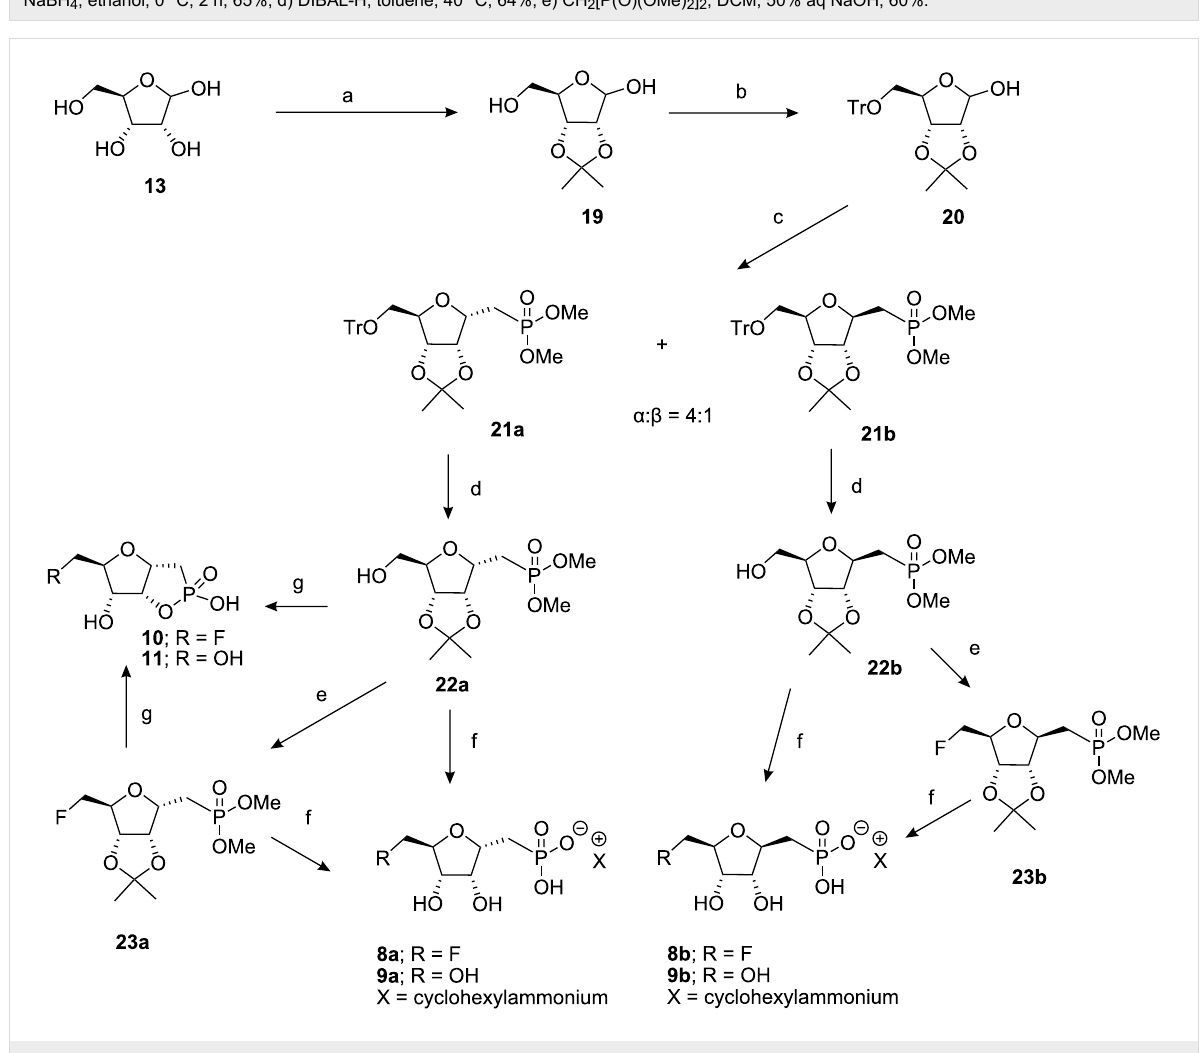
Scheme 2: Synthetic route A. Reagents and conditions: a) acetone, concd H 2 SO 4 (cat.), 6 h, 86%; b) Deoxo-fluor™, DCM, 40 °C, 30 min, 84%; c) NaBH